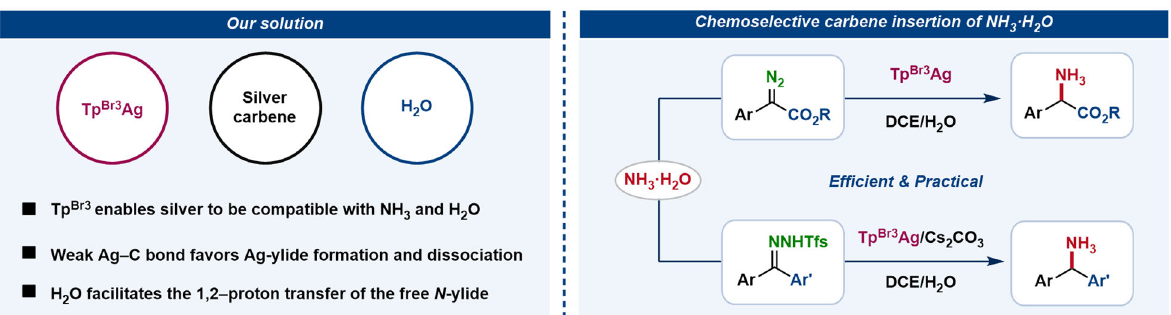
two-phasesystemenableschemoselectivecarbeneinsertionintotheN − Hbondsof NH 3 ·H 2 O. Tp, tris(pyrazolyl)borate; Ar, aryl; Tfs, 2-(tri fl uoromethyl)